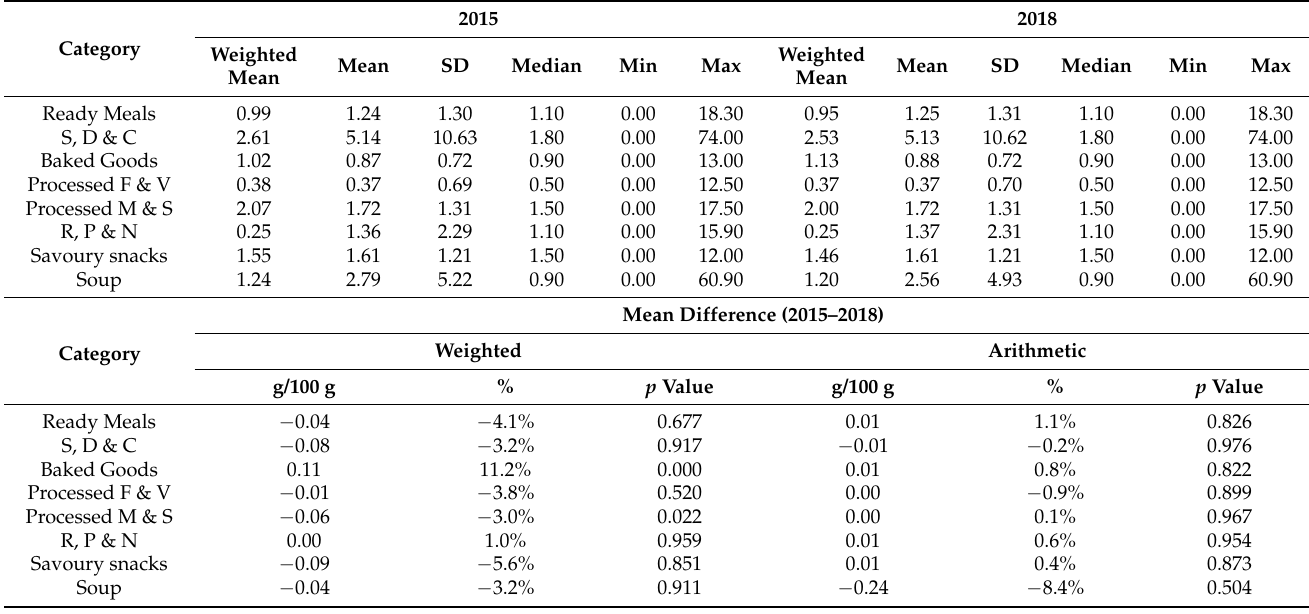
Table 4. Summary statistics and variations of salt content (in g/100 g) for selected packaged food categories in Europe.